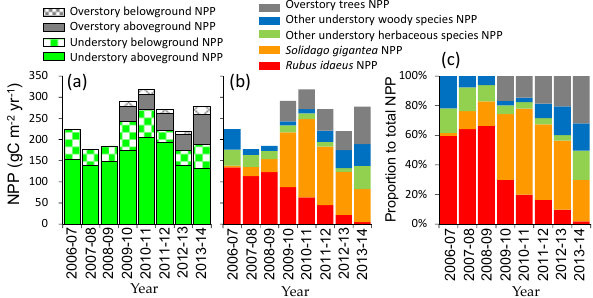
because of the sharp decrease of understory NPP. The contribution of the overstory to total NPP increased from 17% (2010–2011) to 32% (2013–2014) (Figure 5c). Total belowground NPP accounted for 14%–32% of the total NPP during the study period.